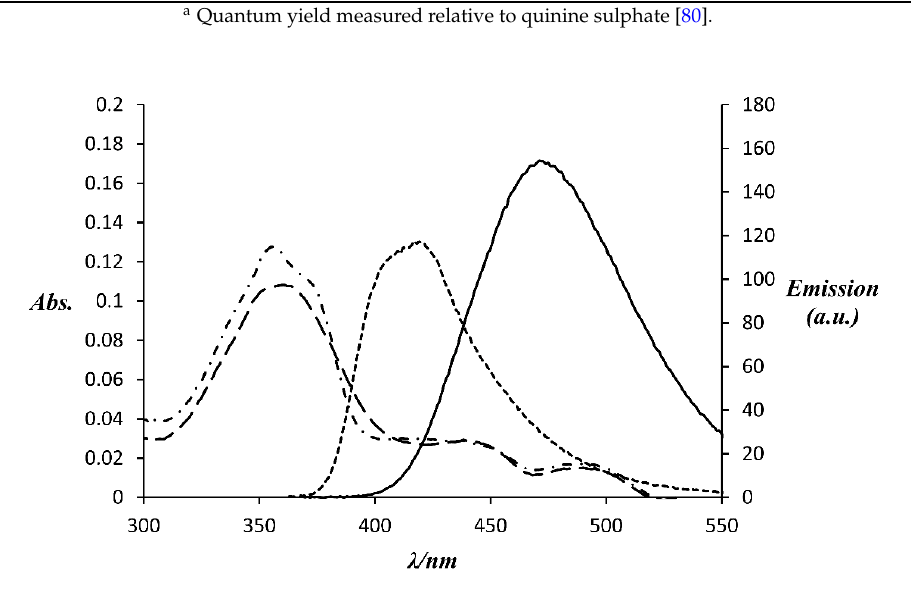
Figure 1. Absorbance and fluorescence emission spectra of Gd(III) complexes (5 µM) in 100 mM HEPES, pH 7.4 (298 K). Dot-dashed line: absorbance of Gd-L, dotted line: emission of Gd-L excited at 356 nm, dashed line: absorbance of “clicked” Gd-L, solid line: emission of “clicked” Gd-L excited at 362 nm.